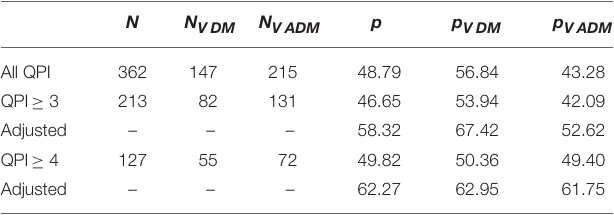
TABLE 3 | Table of PINT data with QPI values and older than 500